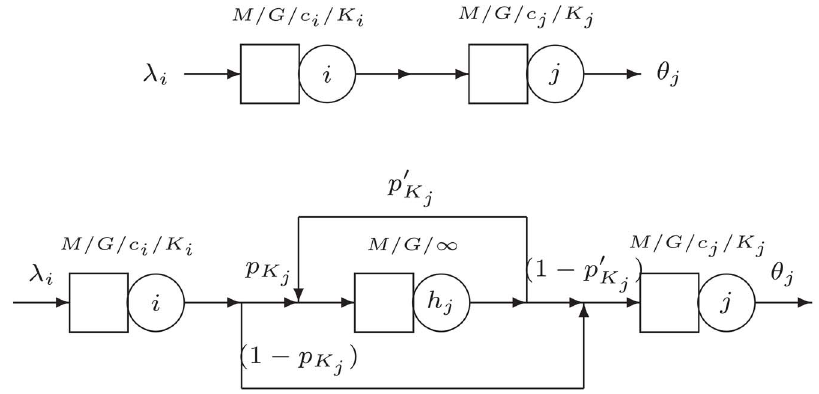
Figure 2. The generalized expansion method.